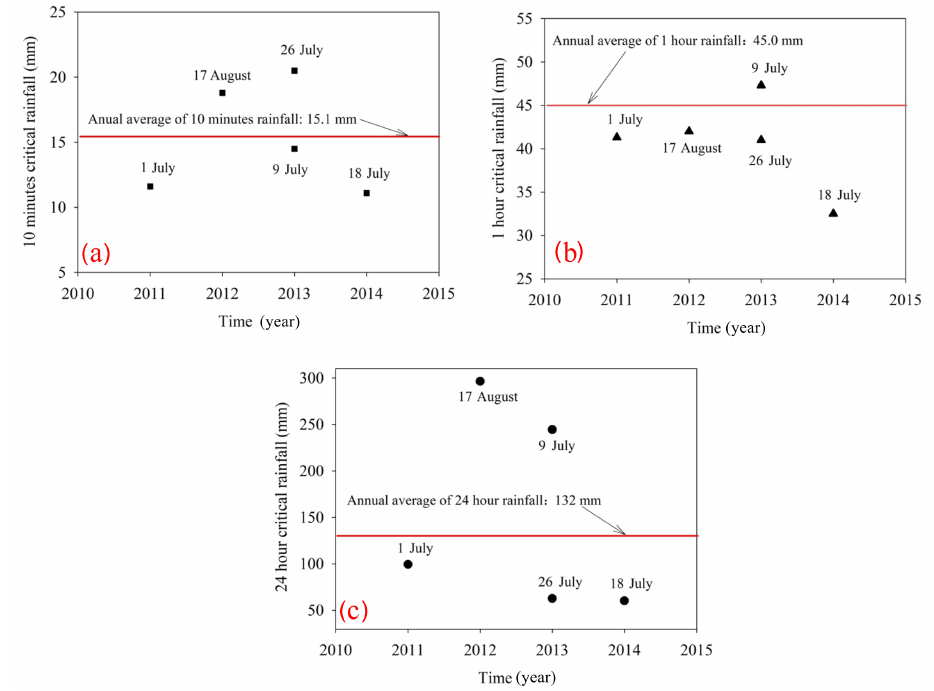
Figure 7. The critical rainfall of debris flows in the Guojuanyan gully.